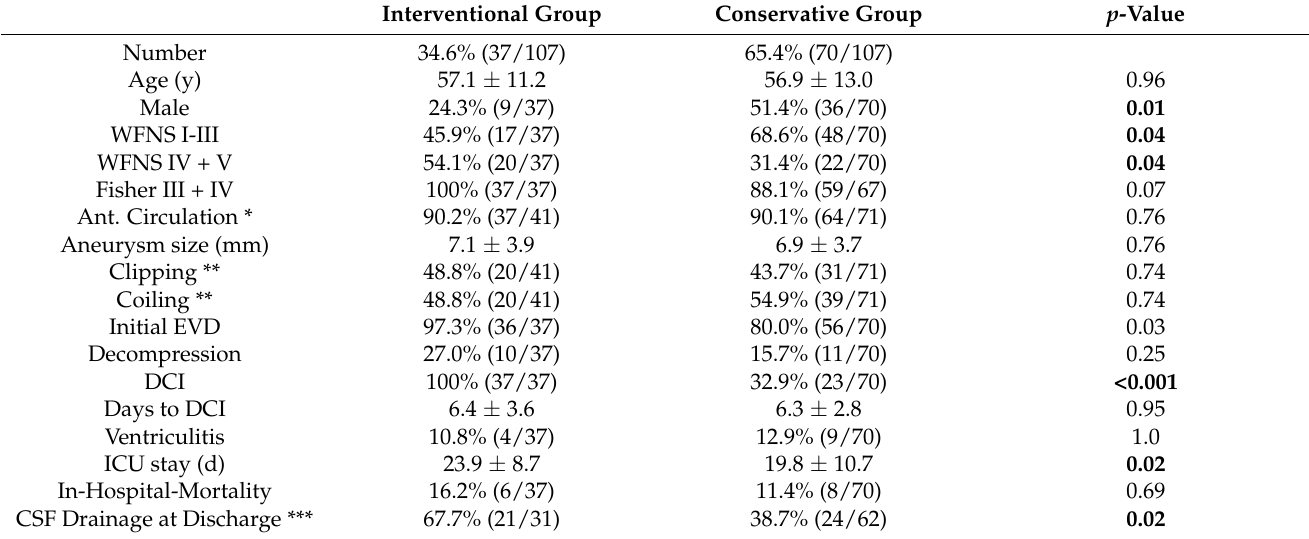
Table 1. Baseline characteristics. WFNS: World Federation of Neurological Surgeons; EVD: External ventricular drainage; DCI: Delayed cerebral ischemia; ICU: Intensive care unit; CSF: Cerebrospinal fluid. Interventional Group Conservative Group p -Value